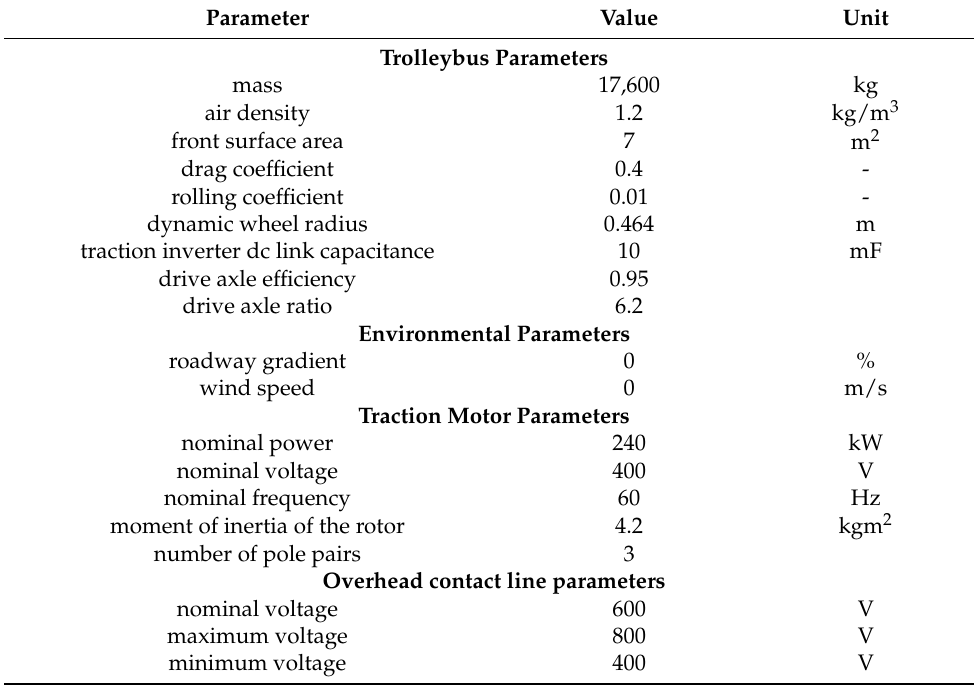
Table 3. Trolleybus parameters and environmental variables used in the simulation